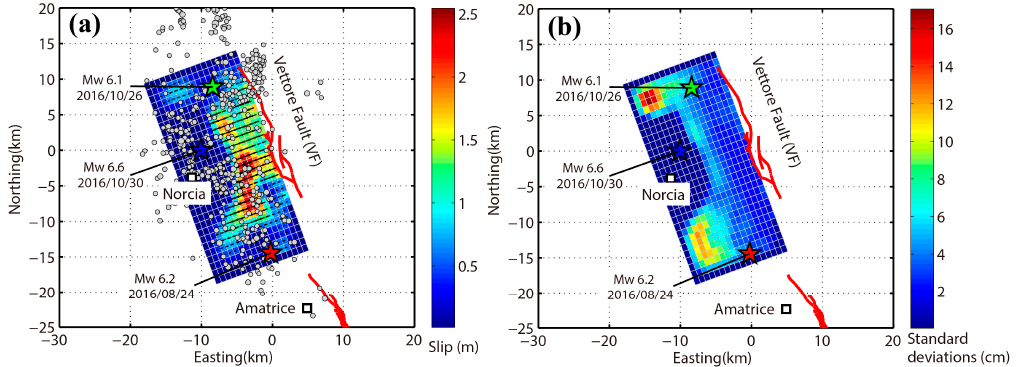
Figure 7. ( a ) Surface projection of the coseismic slip model of 30 October 2016 Norcia earthquake. ( b ) Standard deviations in slip from Monte Carlo estimation with 100 perturbed datasets. Red line represents the active fault. Gray dots denote the aftershocks of ML > 3 from 30 October 2016 to 17 January 2017 [12]. Color shows the slip magnitude in meters, and arrows correspond to the slip directions. White square denotes the city of Norcia and Amatrice. The red star corresponds to the epicenter of 24 August 2016 Amatrice earthquake, the green star denotes the epicenter of 26 October 2016 Visso earthquake, the blue star denotes the epicenter of 30 October 2016 Norcia earthquake [12].